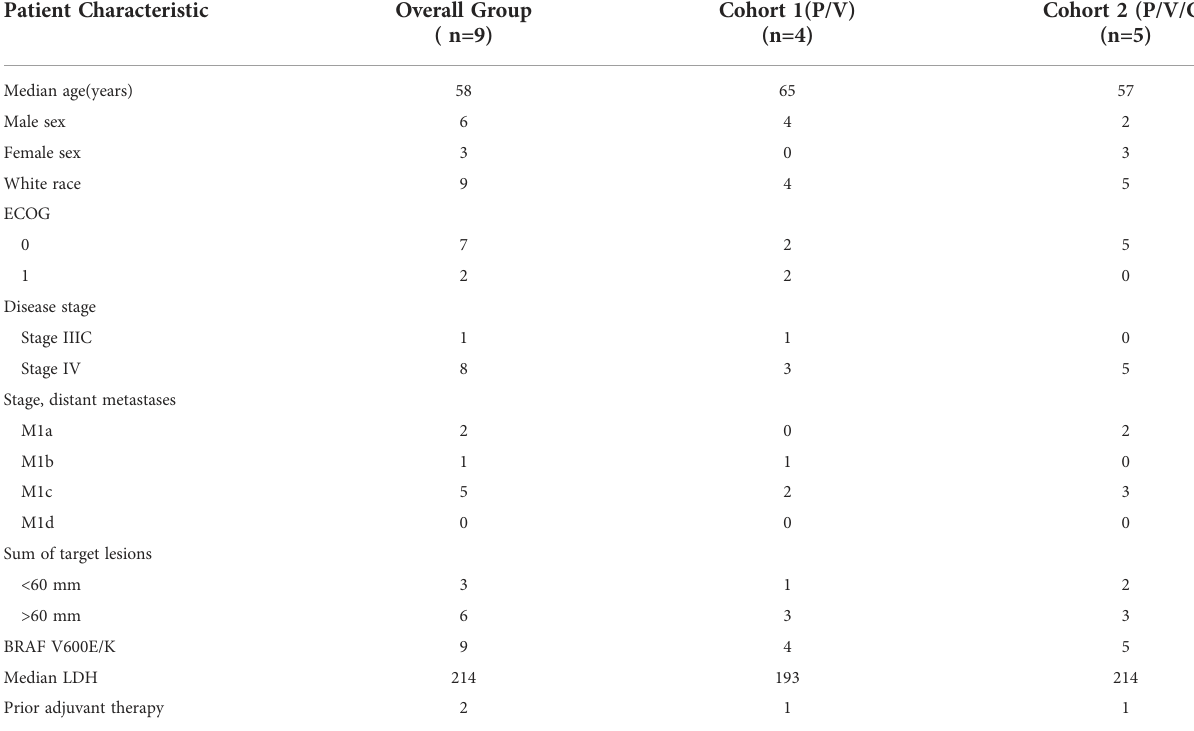
TABLE 1 Patient Characteristics (P/V: pembrolizumab/vemurafenib, P/V/C: pembrolizumab/vemurafenib/cobimetinib). Patient